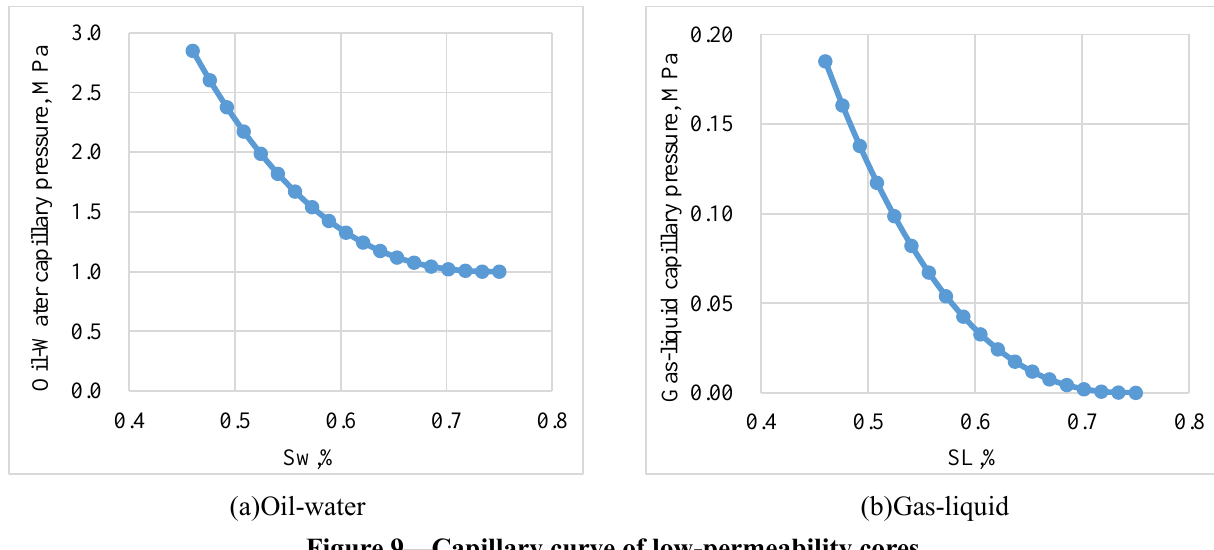
Figure 9—Capillary curve of low-permeability cores.